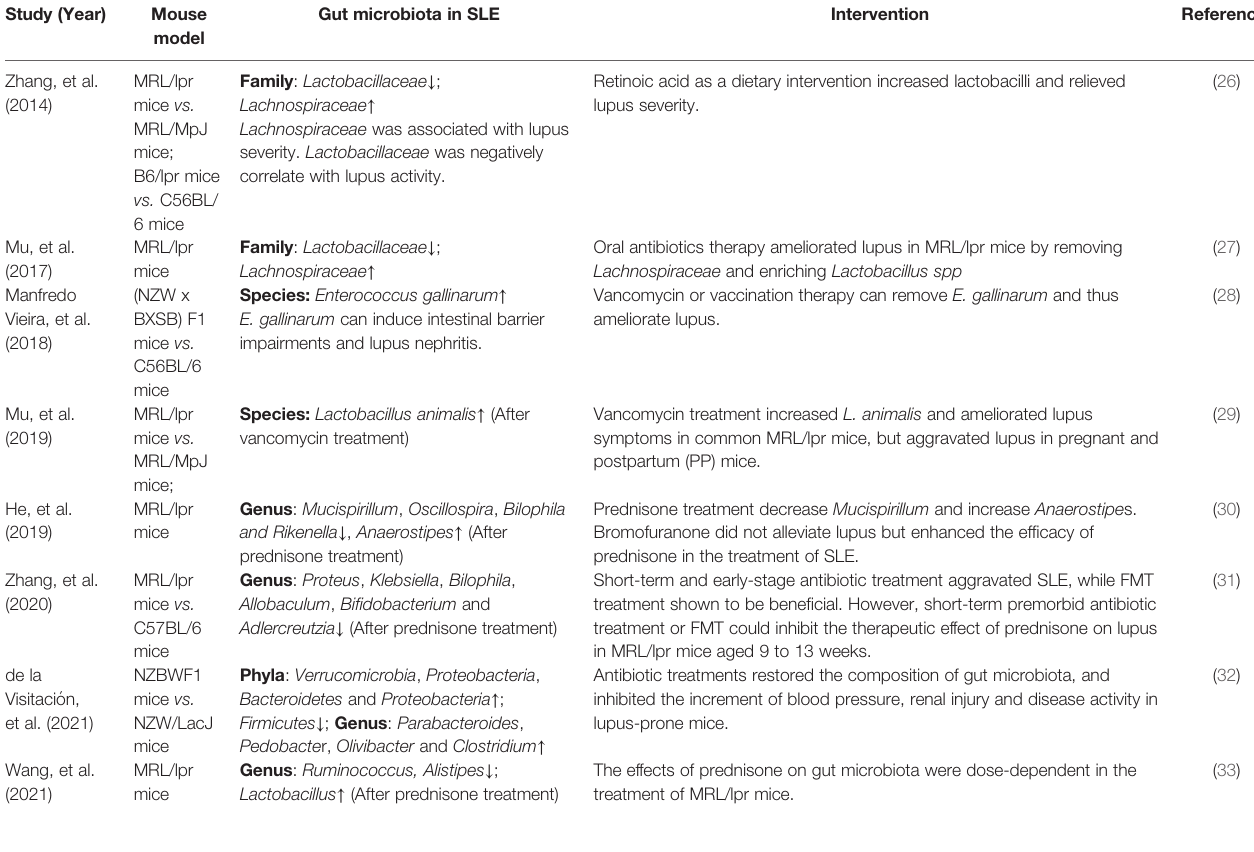
TABLE 2 | Gut microbiota dysbiosis in lupus mouse